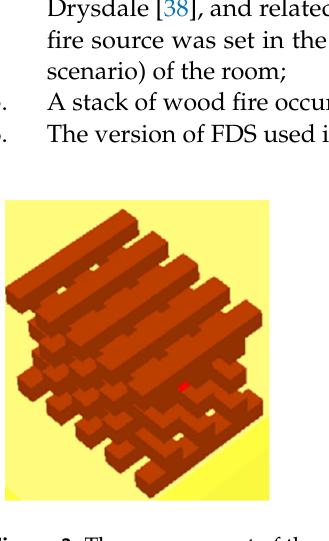
Figure 4. The measured positions of temperature at 0.1 m height from the ceiling. ( a ) square room, ( b ) rectangular room.